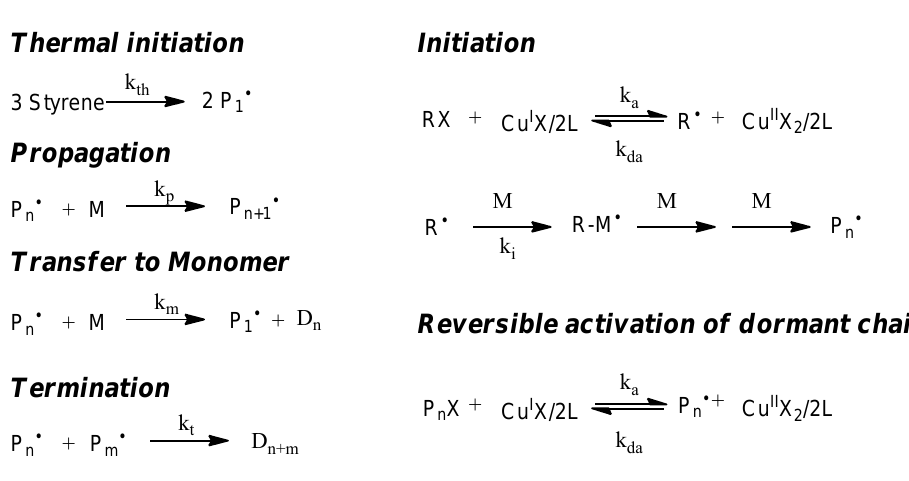
Figure 8. Kinetic model of atom transfer radical polymerization (ATRP).